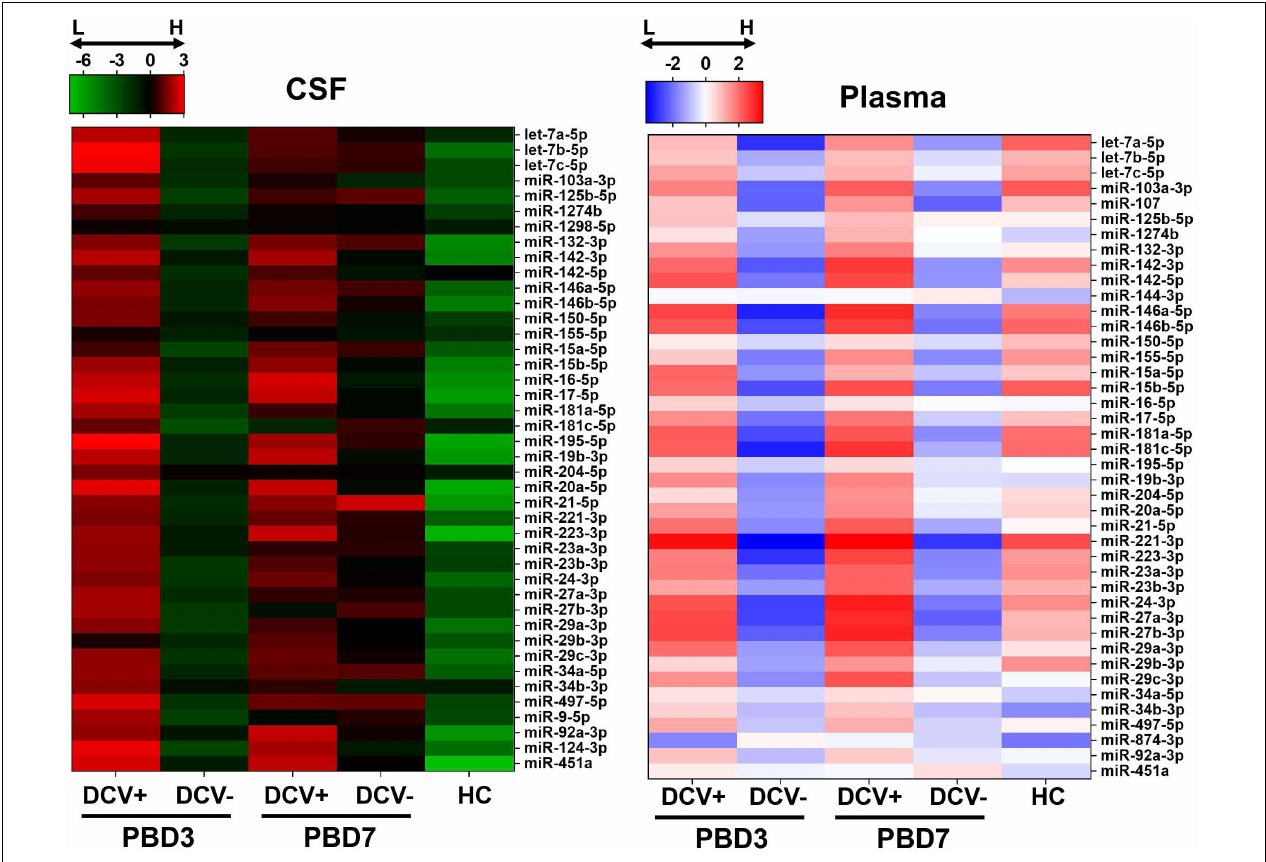
FIGURE 2 | Heatmaps of overall miRNA expression in CSF and plasma specimens collected from aSAH patients and healthy controls (HC). Normalized – (cid:49) C RT was used to generate the mean expression for each miRNA in each